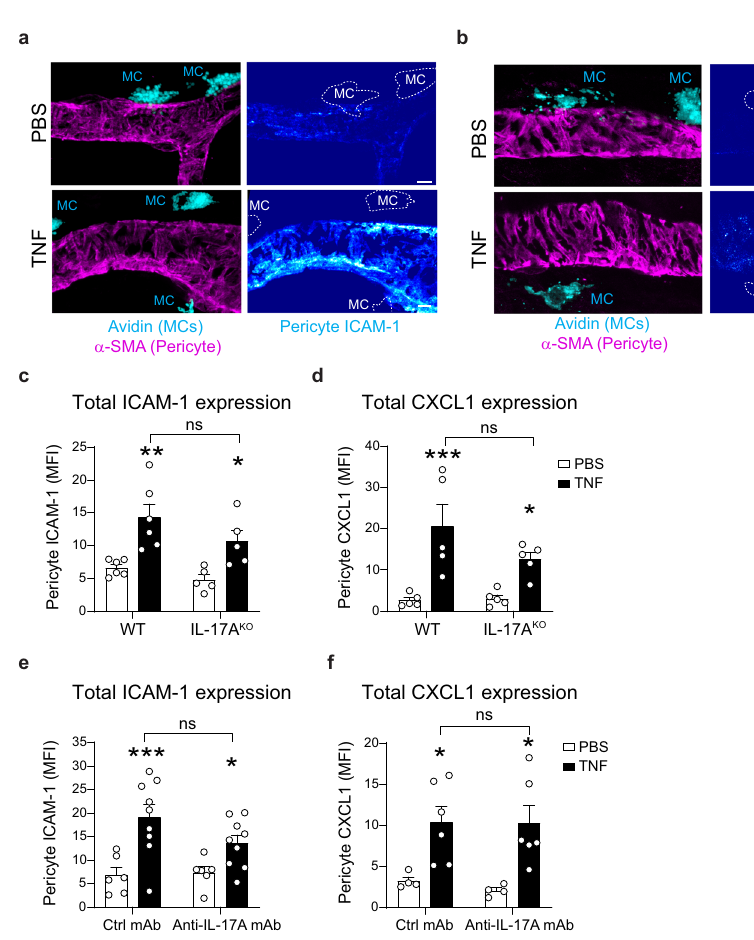
Fig. 4 | Pericyte ICAM-1 and CXCL1 expression is increased in vessels with MCs but totalexpressionis notimpacted by IL-17A. a – d Cremaster musclesofWT or IL-17A KO micewerestimulatedwithTNF(300ng)orPBSfor4h.Cremastermuscles werecollectedandimmunostainedforMCs(avidin),pericytes( α -SMA)andICAM-1 or CXCL1. a – b Images of venules showing a ICAM-1 or b CXCL1 expression (pseu- docolourintensitygradient)onpericytes(purple)andMCs(cyan),dashedlinesthe limitof MC,scale bars, 5 µ m. c , d Quanti fi cationof c ICAM-1MFI( n =6 WT, n =5 IL- 17A KO mice) and d CXCL1 MFI ( n =5 mice) on pericytes. e , f Cremaster muscles of